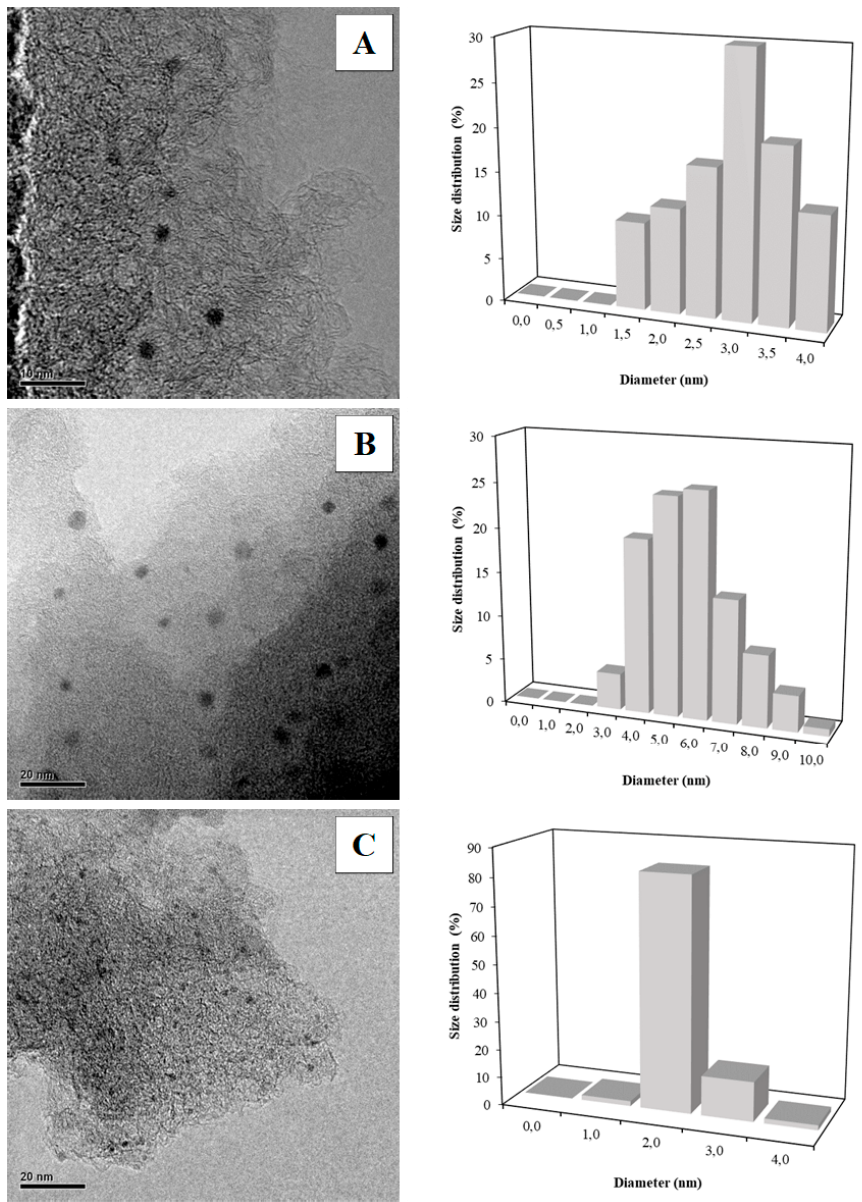
Figure 2. TEM images (left) and metal particles size distributions (right) of catalysts reduced at 450 °C: ( A ) Pt/C; ( B ) Pd/C; ( C ) Rh/C. ( A ) Pt/C; ( B ) Pd/C; ( C )